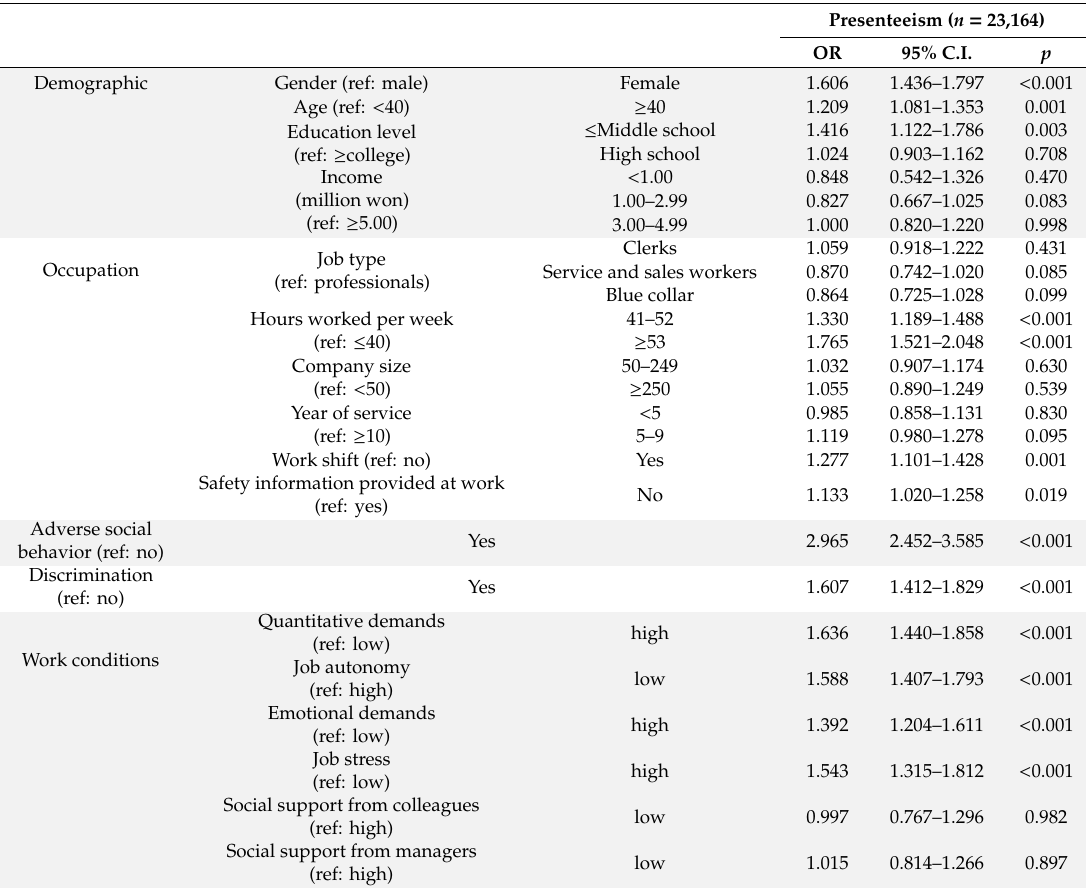
Table 2. Factors related to